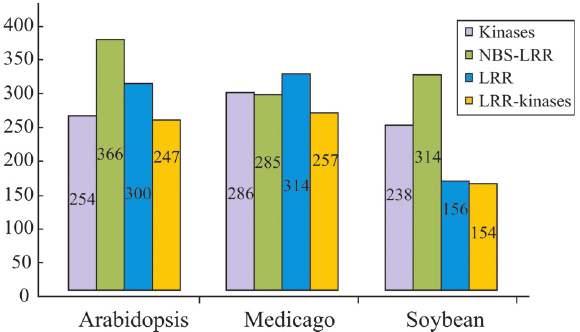
Figure 2 - Distribution of R gene families in soybean, Arabidopsis and Medicago in the four main R gene categories, considering their conserved domains.Columnnumberscorrespondtotheamountofnon-redundantse- quences for each class.